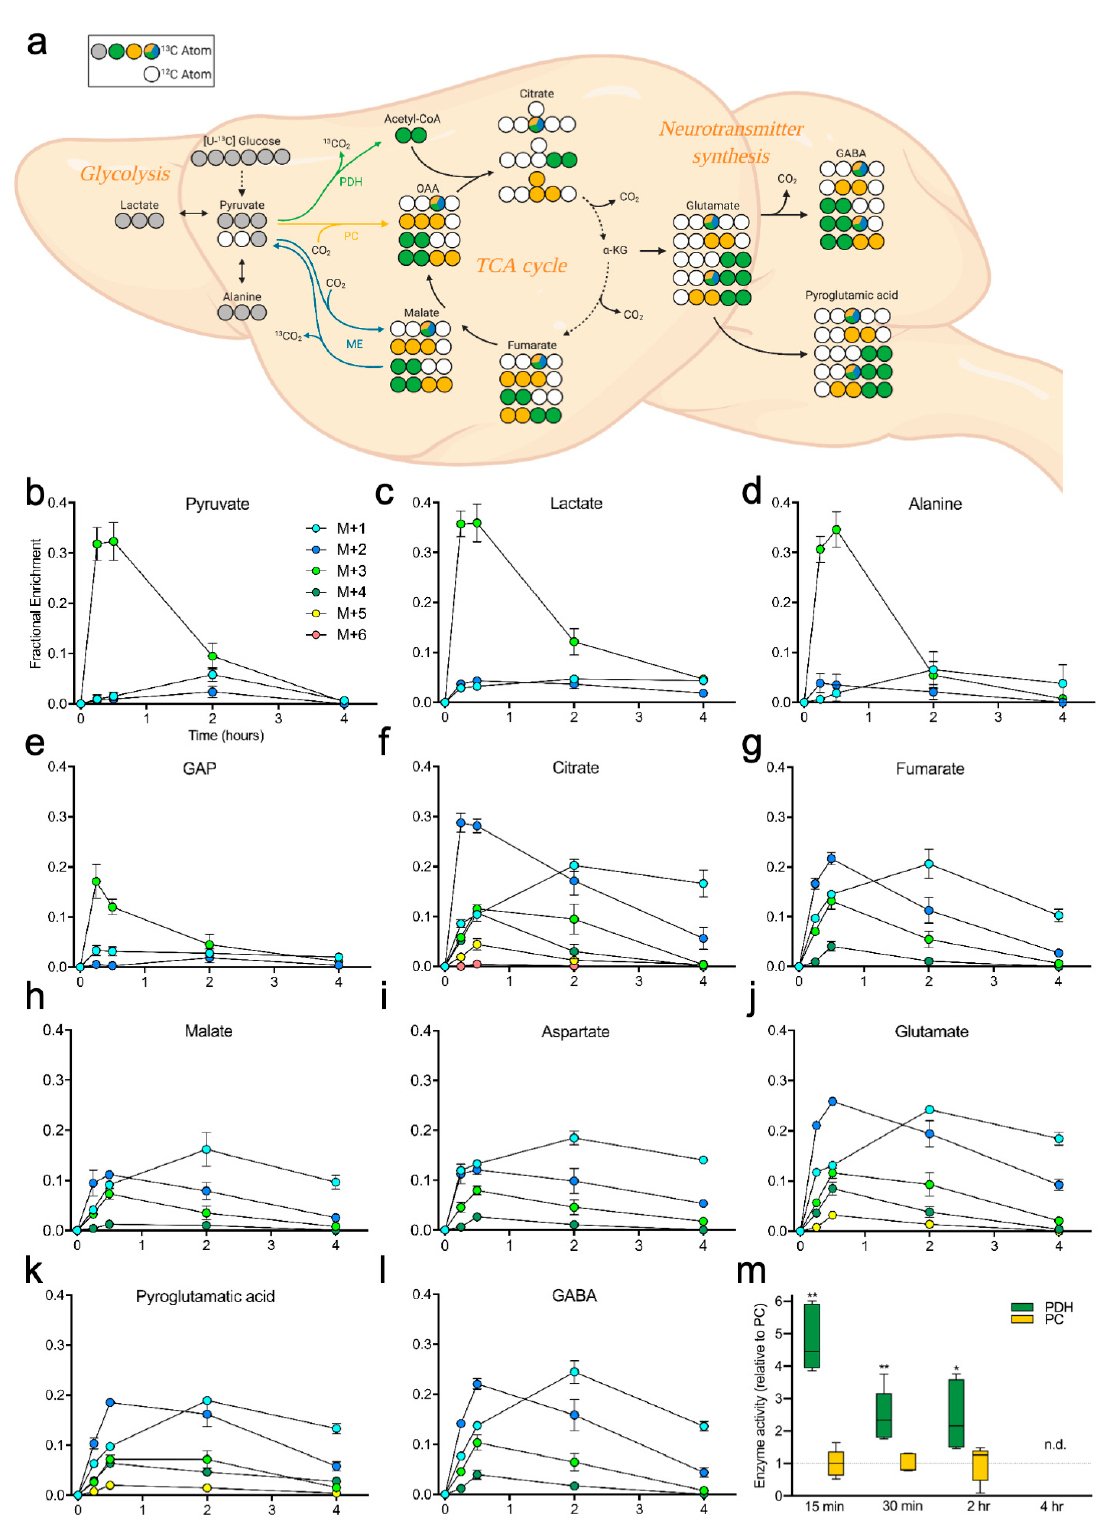
Figure 2. Carbon tracing in the brain after oral gavage of [U- 13 C] glucose. ( a ) Example diagram tracing of glucose carbon through glycolysis, TCA cycle, and neurotransmitters in whole-brain tissue from mice receiving oral gavage of [U- 13 C] glucose (not all possible labeled isotopologues are shown). Carbons are colorcodedbasedonthepathwayand / orenzymefromwhichthecarbonwasderived. Greycircles: 13 Cfrom glycolysis; green: 13 C from pyruvate dehydrogenase (PDH); yellow: 13 C from pyruvate carboxylase